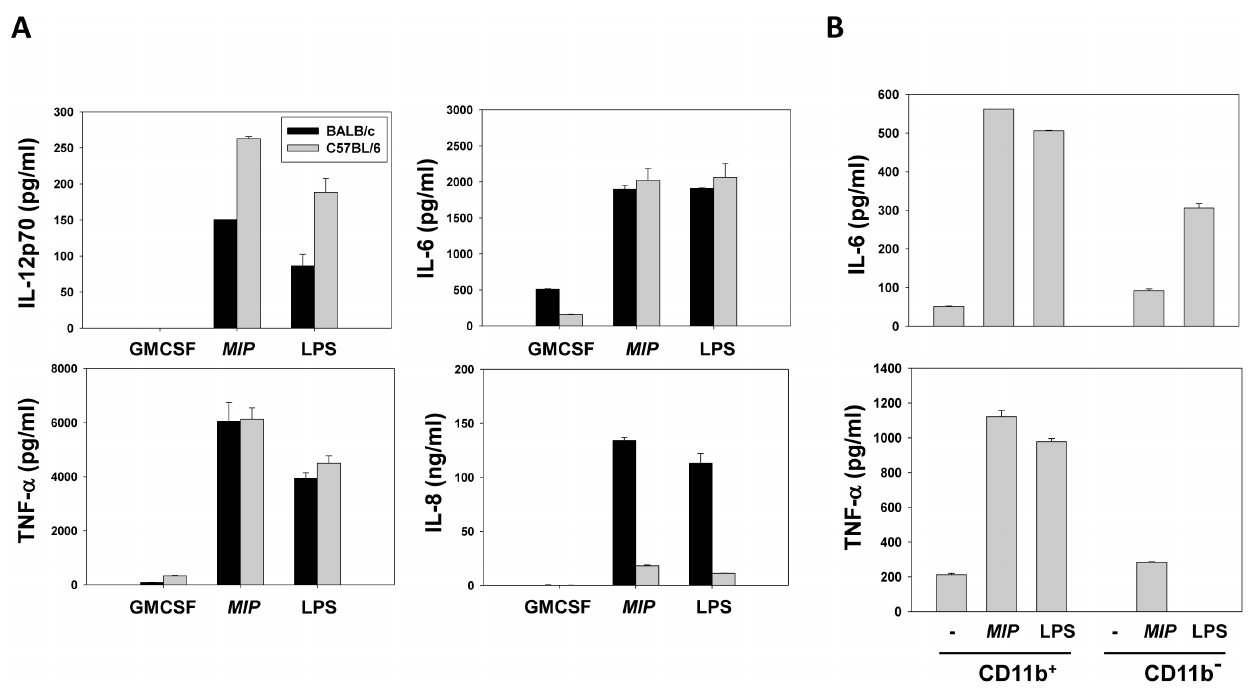
Figure 2. Inflammatory activity of MIP. (A) BMDC (derived from BALB/c and C57BL/6 mice) were treated with MIP (or LPS a control) and indicated cytokines were quantified. Bars represent arithmetic mean 6 standard error. (B) IL-6 and TNF- a secretion upon incubation of MIP or LPS with CD11b + and CD11b 2 splenic cells derived from C57BL/6 mice.